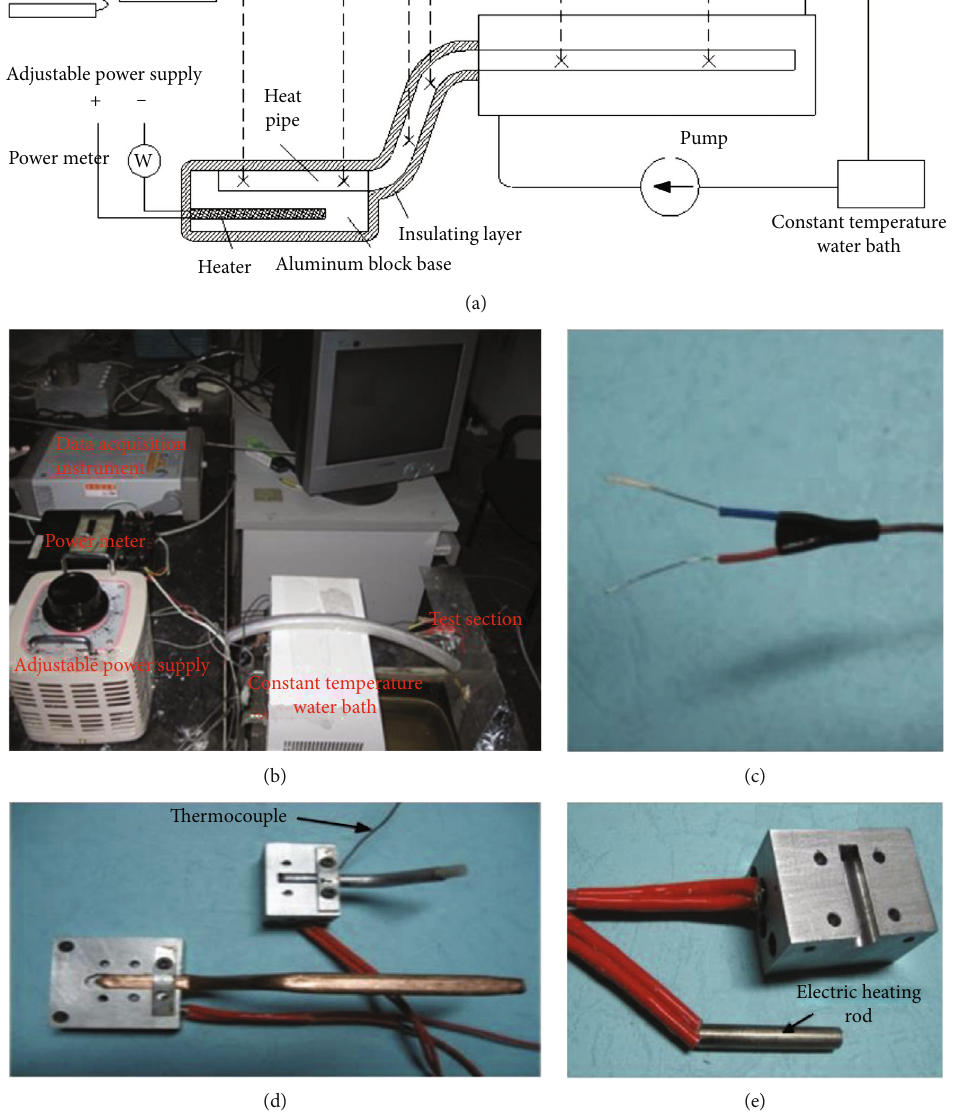
Figure 1: Experimental system of the bent heat pipe: (a) experimental schematic, (b) experimental system rig, (c) thermocouples, (d) metal sintered powder heat pipe, and (e) electric heating